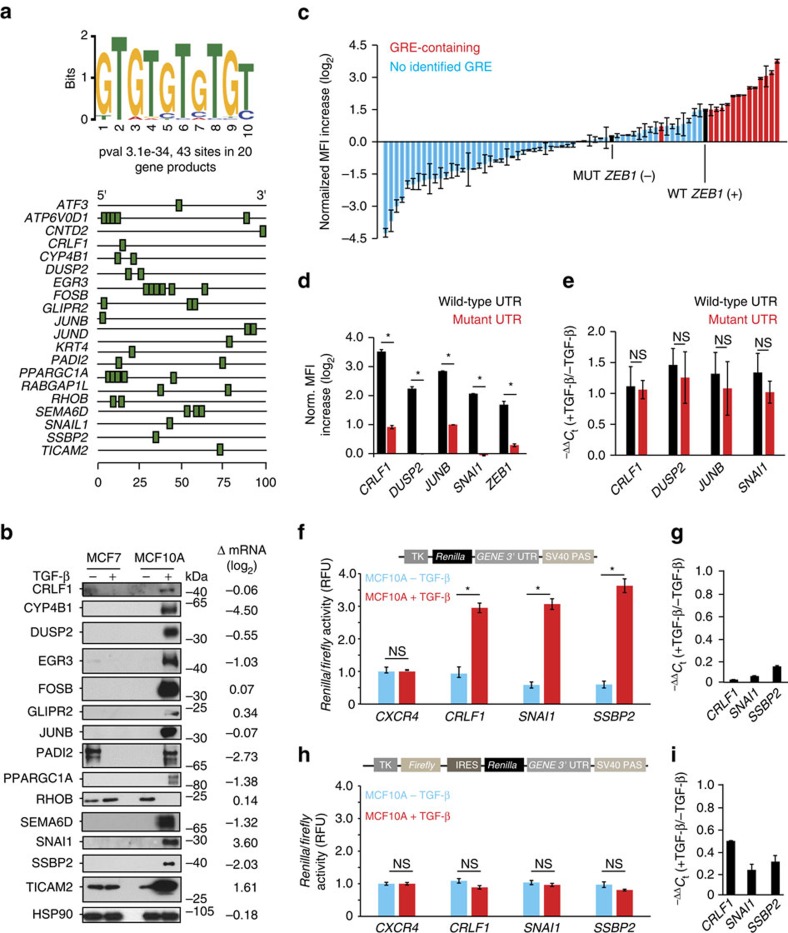
GREs confer context-dependent translational regulation to mRNA transcripts.(a) MEME algorithm output of an enriched GRE within the 3′-UTRs of the putative positive regulator set and schematic representation of GRE location in 3′-UTR of indicated transcripts. (b) Immunoblot analysis of proteins encoded by GRE-containing mRNAs in untreated and TGF-β-treated MCF7 and MCF10A cells. HSP90 serves as a representative loading control. The relative changes in total mRNA expression (MCF10A±TGF-β) of each GRE-containing gene in total mRNA as quantified by qRT-PCR are indicated on the right. (c) Reporter assay quantifying the relative tRFP expression from 70 3′-UTR reporters in TGF-β-treated MCF10A cells relative to untreated controls. Wild-type (WT) and mutant (MUT) ZEB1 UTRs (black) serve as positive and negative controls, respectively. Data were normalized to relative tGFP expression. (d) Reporter assay quantifying the relative tRFP expression from indicated WT 3′-UTRs (black) and those in which the GRE (or miR-200 binding sites for ZEB1) (red) have been deleted in TGF-β-treated MCF10A cells relative to untreated controls. Data were normalized to relative tGFP expression. (e) qRT-PCR of relative mRNA expression of indicated WT and GRE-mutant tRFP reporters in untreated and TGF-β-treated MCF10A cells. (f) Reporter assay quantifying the relative Renilla luciferase expression from the indicated 3′-UTR luciferase reporters in TGF-β-treated MCF10A cells relative to untreated controls. Renilla activity was normalized to Firefly luciferase activity and this ratio is expressed relative to the parental control reporter (pRL-TK CXCR4 6x). (g) qRT-PCR of relative mRNA expression of indicated Renilla Luciferase reporters (pRL-TK) in untreated and TGF-β-treated MCF10A cells. (h) Reporter assay quantifying the relative Renilla luciferase expression from the indicated 3′-UTR luciferase reporters driven from an internal ribosomal entry site in TGF-β-treated MCF10A cells relative to untreated controls. Renilla activity was normalized to Firefly luciferase activity. Data are normalized to a control reporter containing the pRL-TK CXCR4 6x 3′-UTR. (i) qRT-PCR of relative mRNA expression of indicated Renilla luciferase reporters driven by EMCV IRES (pFR-EMCV) in untreated and TGF-β-treated MCF10A cells. All panels (excluding a) are representative of a minimum of three experimental replicates. For immunoblots depicted, samples were derived from the same experiment and gels were processed in parallel. Error bars in d depict s.d. of the mean, error bars in e,f,h depict s.e.m. NS indicates non-significant, *P≤0.05, (Student's t-test). Full scans of blots are shown in Supplementary Fig. 8.